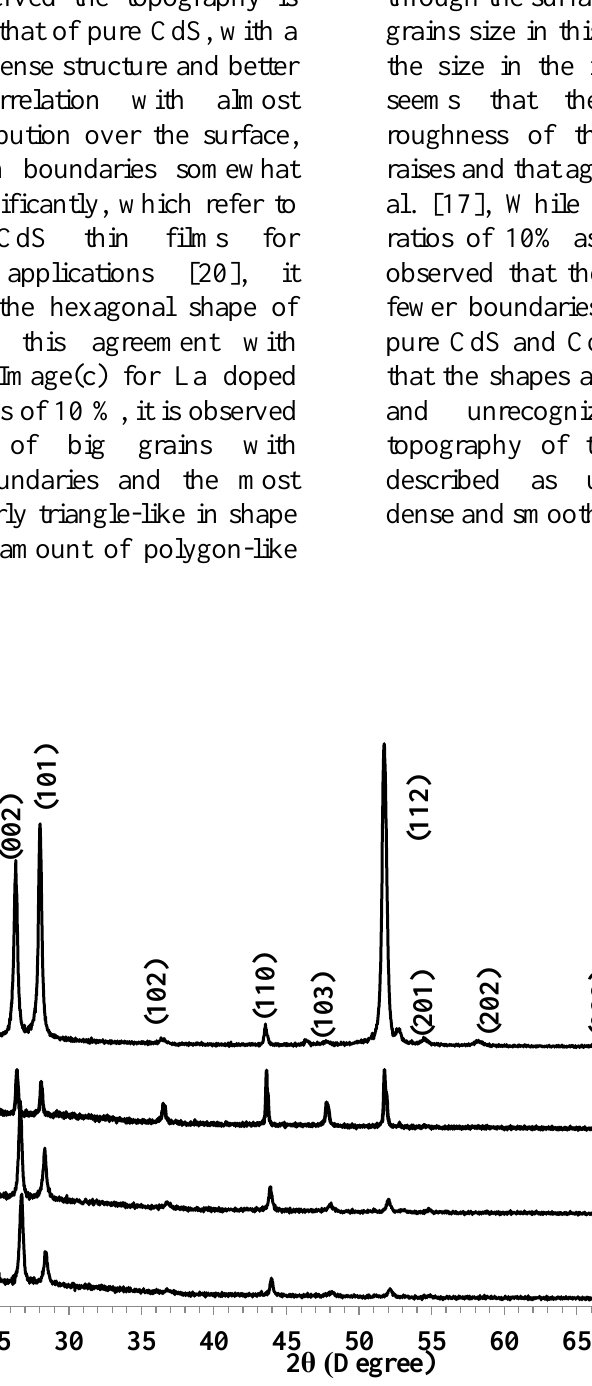
Fig. 1: X-Ray diffraction patterns for pure CdS and (Ce, La and Nd) doped CdS at 10%.